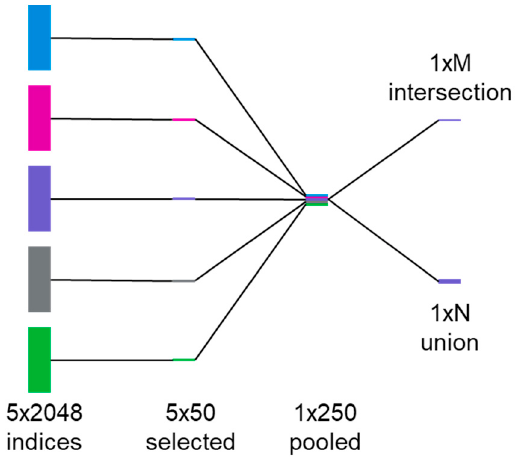
Figure 3. Process for random forest (RF) feature selection, starting by finding 50 out of 2048 most important indices of ECFP using 5 different RF models and returning the intersection and union sets of the pooled indices. Table 2. Number of features in the intersection (Int) and union (Uni) sets for each property after the RF feature selection procedure.